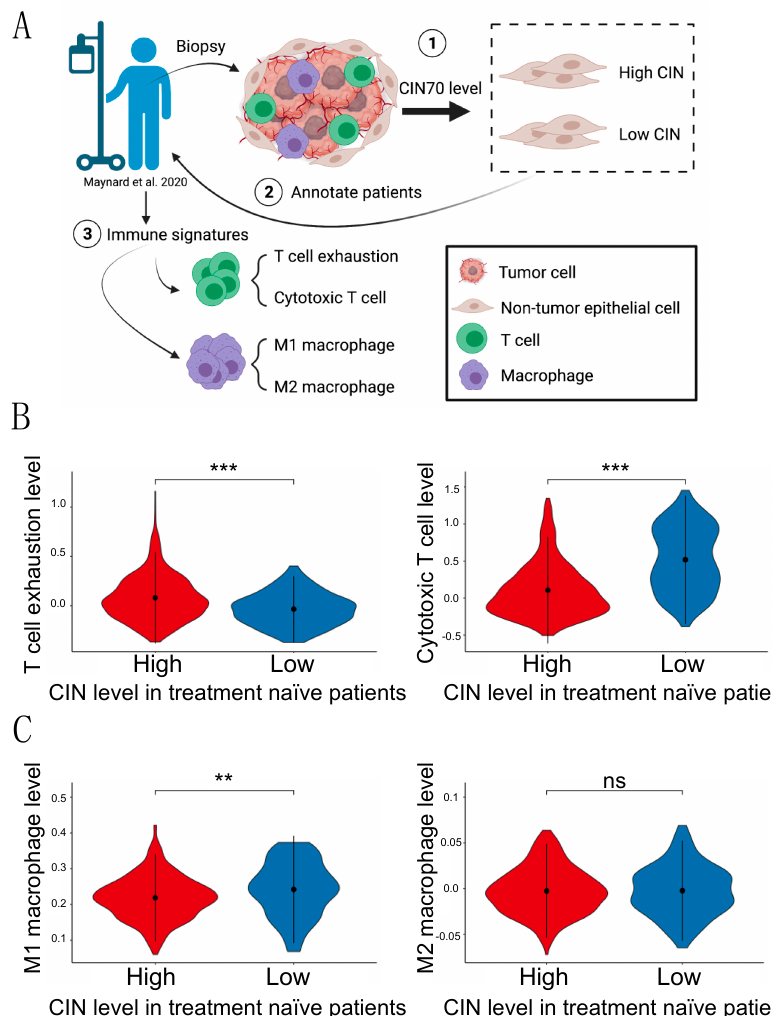
Figure 6. Different immune signatures in high and low CIN patients. ( A ) Schematic showing the experimental design. ( B ) Levels of T cell exhaustion and cytotoxic T cells in samples collected before treatment (treatment naïve) in high and low CIN patients. ( C ) M1 and M2 macrophages cells in samples collected before treatment (treatment naïve) in high and low CIN patients. The Y-axis shows the scores of each signature, while the dot in each graph represents the mean value and the lines connecting the dot represent the standard deviations. ns, not significant; ** p < 0.01; *** p < 0.001 Two-tailed t -test.